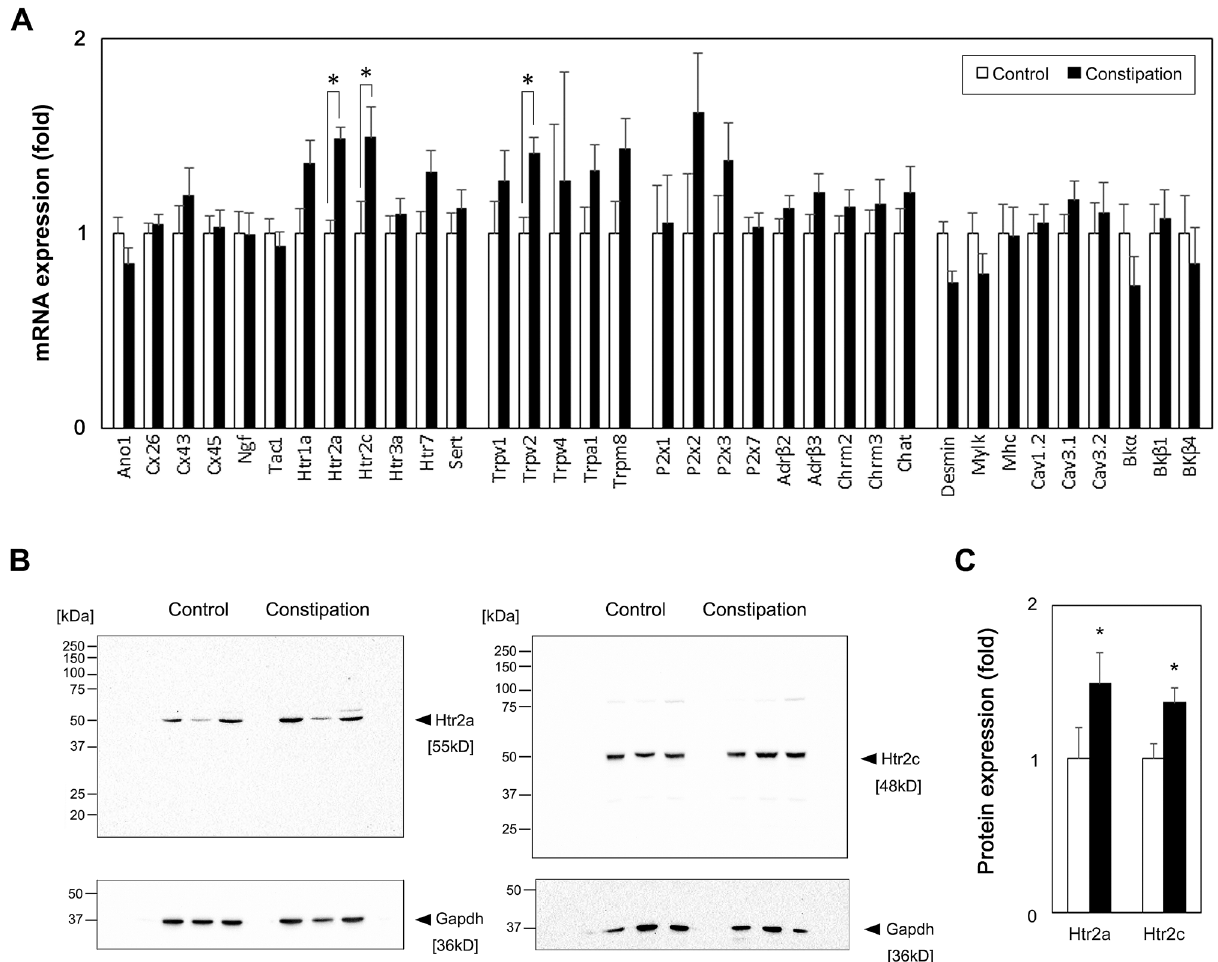
Figure 5. Gene expression analysis in the bladders. ( A ) The level of mRNA expression of each gene is presented as the fold difference to that in the control group (N = 5 per group). ( B ) The protein expression comparison. Representative Western blotting results for Htr2a (top left), Htr2c (top right) and Gapdh (bottom). ( C ) Summary of relative protein expression levels of Htr2a and Htr2c normalized with Gapdh (right). Mean ± SE, *p < 0.05 vs. the control group. Figures were prepared using Adobe Photoshop CS6 and GraphPad Prism 8.4.3 (https ://www.graph pad.com/scien tific -softw are/prism